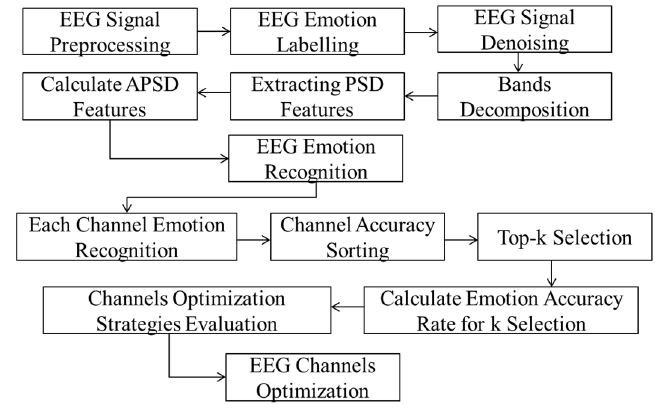
Figure 3. EEG-based emotion recognition model flow work.